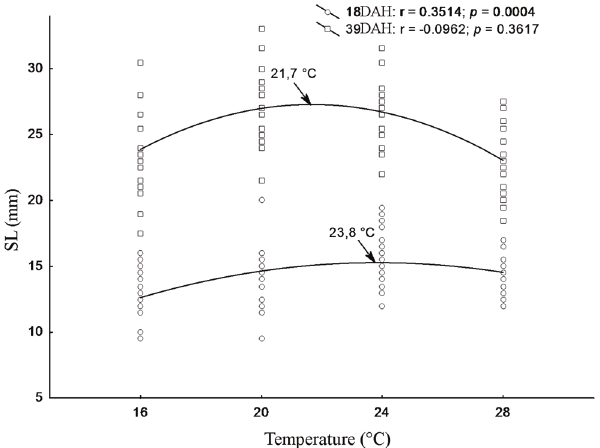
Fig. 4. Effect of temperature on growth in standard length (SL) of Austrolebias wolterstorffi under different ages (DAH = days after hatching). The arrows indicate the inflection points of